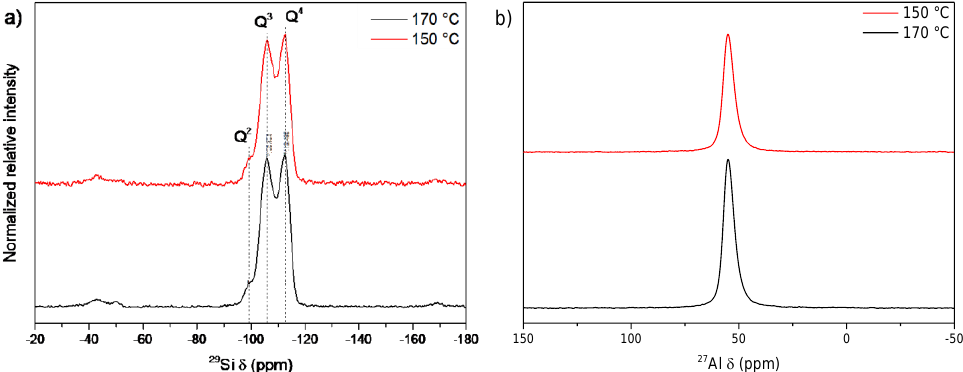
Figure 3. Solid-state NMR spectra of ( a ) 29 Si and ( b ) 27 Al in the samples synthesized at 170 °C and 150 °C for 24 h.